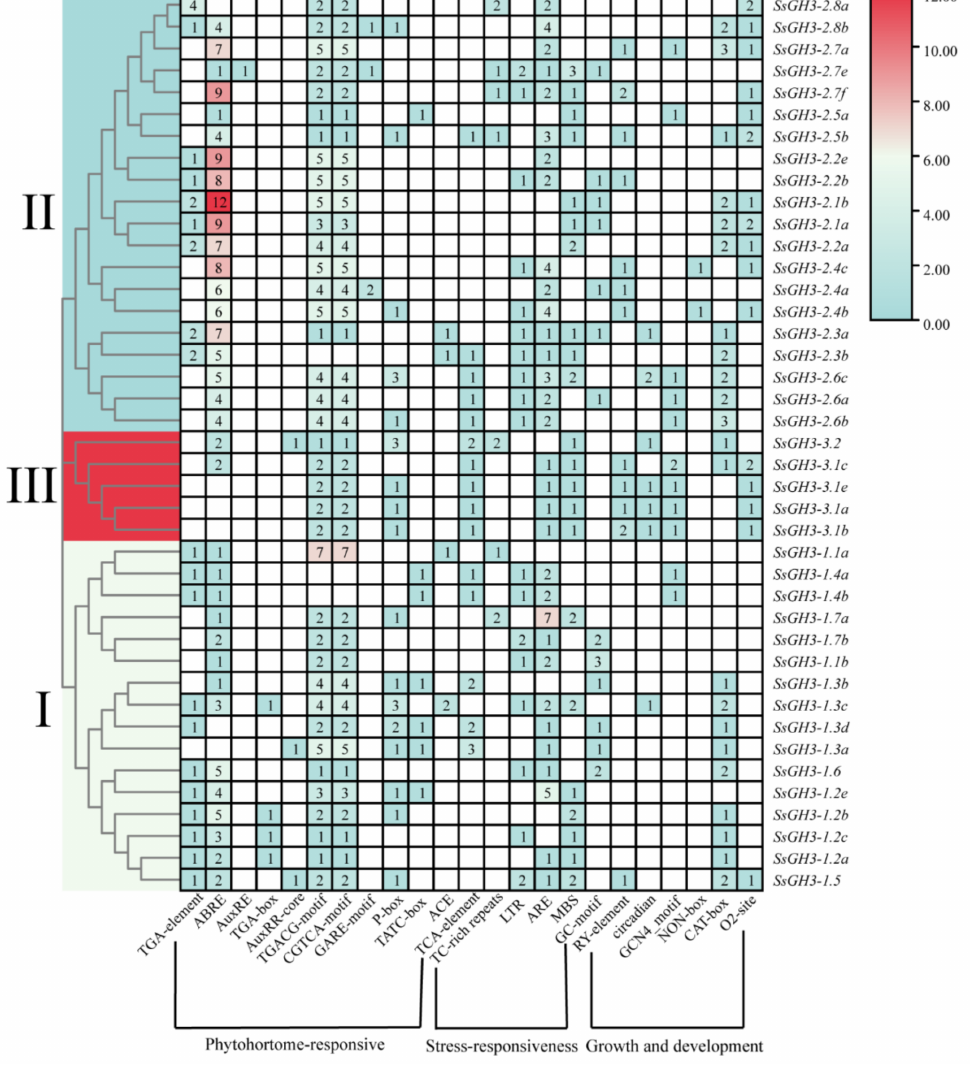
Figure 5. Cis -regulatory element analysis of the SsGH3 family genes. Different colors and Latin numbers (I, II and III) on the phylogenetic tree represent three subgroups of the SsGH3 genes. The number of each cis -regulatory element is shown in the heatmap box ranging from blue to red, with the white boxes indicating no corresponding cis -regulatory